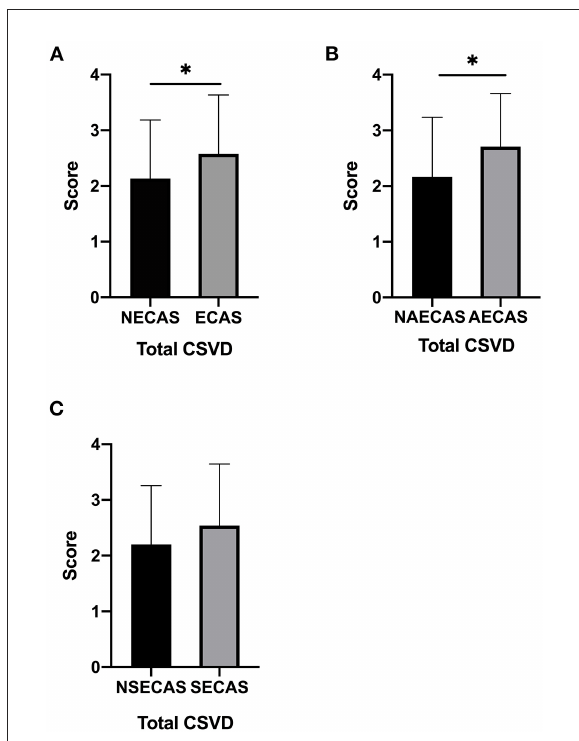
FIGURE3 (A–C) The Fazekas score in patients with or without severe extracranial arterial stenosis or occlusion, with or without severe symptomatic extracranial arterial stenosis or occlusion, and with or without severe asymptomatic extracranial arterial stenosis or occlusion. P < 0.05 was considered to indicate statistical significance. SECAS, symptomatic extracranial arterial stenosis; AECAS, asymptomatic extracranial artery stenosis; ECAS, extracranial artery stenosis; NSECAS, no symptomatic extracranial arterial stenosis; NAECAS, no asymptomatic extracranial artery stenosis; NECAS, no extracranial artery